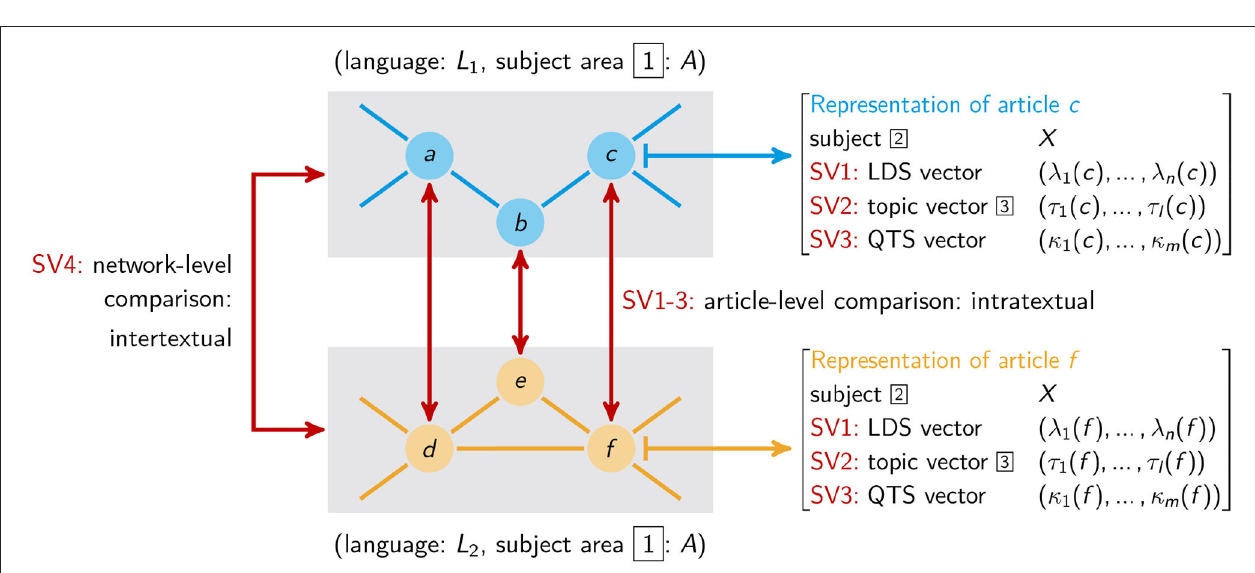
FIGURE 6 | Three-level topic model of subject areas [1], subject instances [2], and topic distributions [3] extended by Quantitative Text Structure (QTS) and Logical Document Structure (LDS) vectors (of m and n dimensions, respectively). SV stands for Similarity View